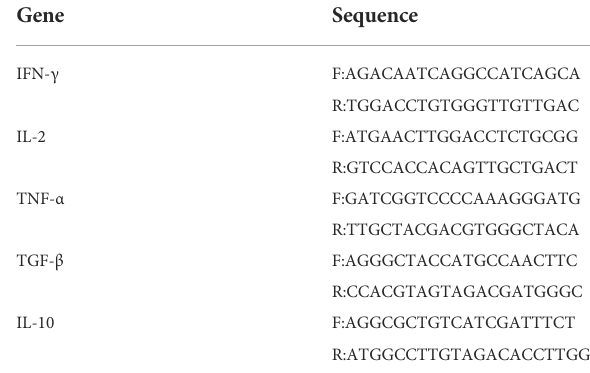
TABLE 3 Primer sequences of the target